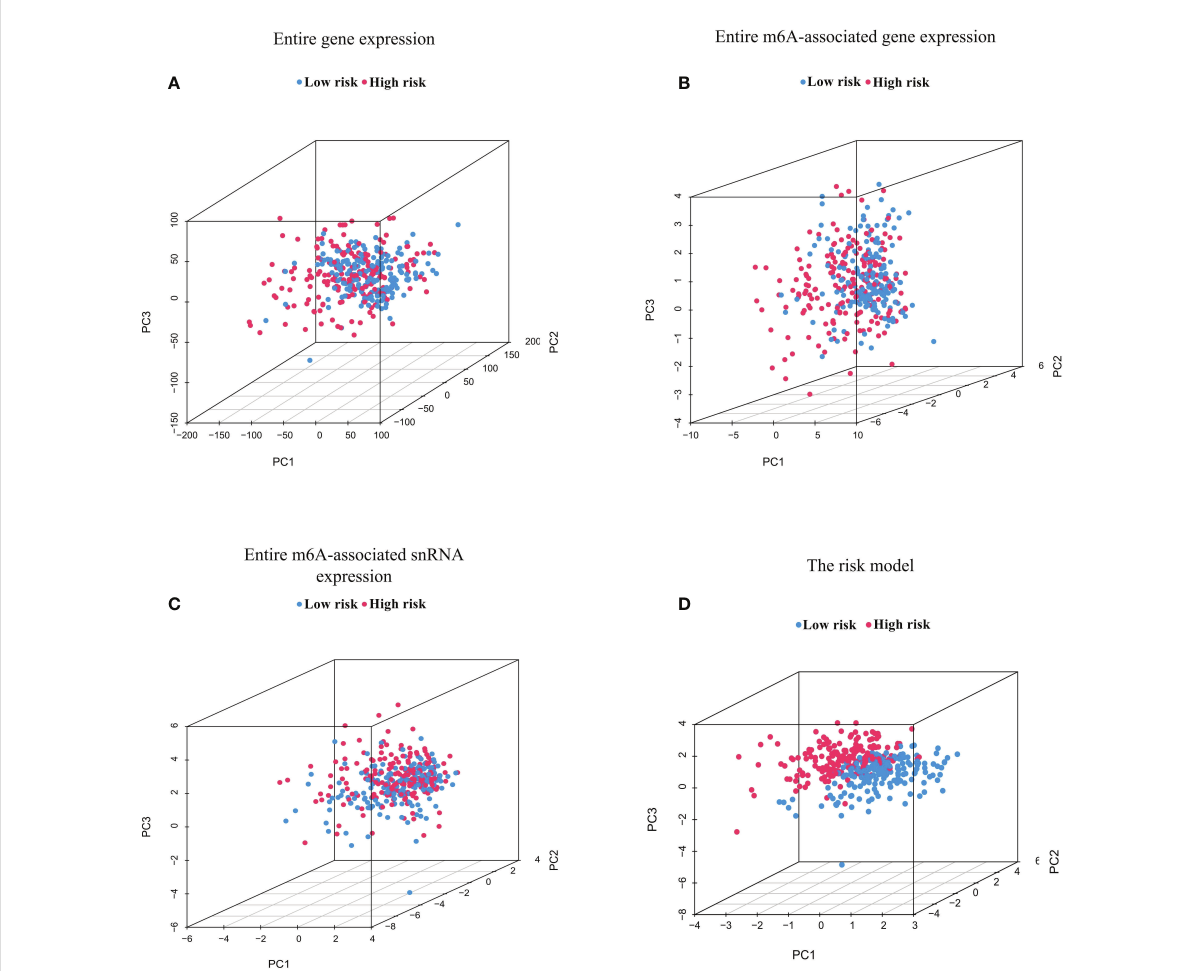
FIGURE 4 Principal component analysis (PCA) between high- and low-risk groups based on m6A-associated snRNAs. PCA between high- and low-risk groups based on the entire gene expression pro fi les (A) , the entire m6A-associated gene expression pro fi les (B) , the entire m6A-associated snRNA expression pro fi les (C) , and the risk model of eight m6A-associated snRNAs (D)